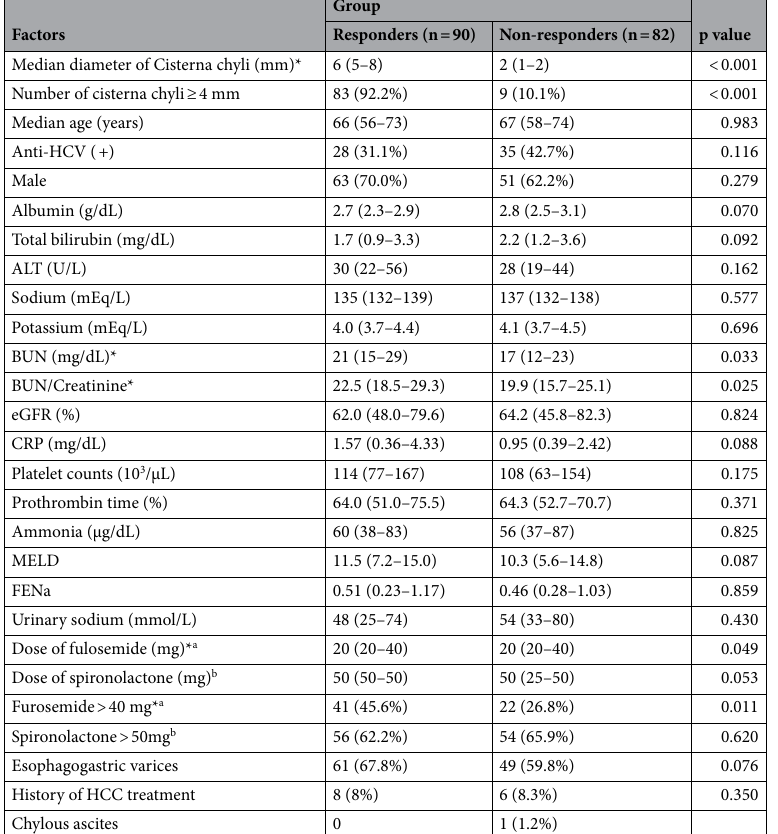
Table 2. Patient characteristics for tolvaptan responders vs. non-responders. HCV hepatitis C virus, ALT alanine aminotransferase, BUN blood urea nitrogen, eGFR estimated glomerular filtration rate, CRP c-reactive protein, MELD model for end-stage liver disease, FENa fractional excretion of sodium: (urine sodium/serum sodium)/(urine creatinine/serum creatinine, HCC hepatocellular carcinoma. a Dose of furosemide during tolvaptan treatment. b Dose of spironolactone during tolvaptan treatment. *p < 0.05.